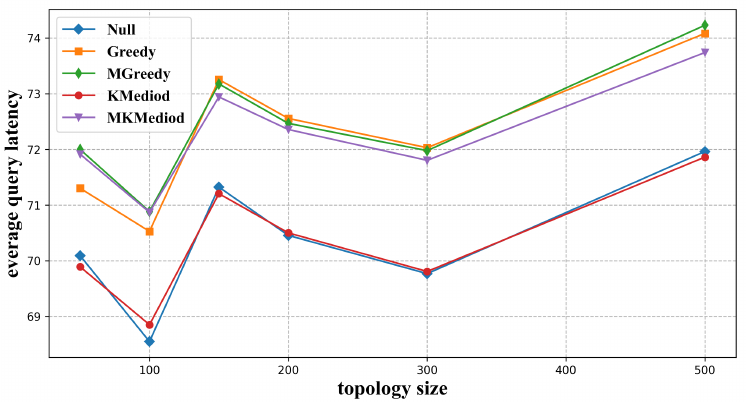
Figure 8. Average resolution service latency of each algorithm with different network